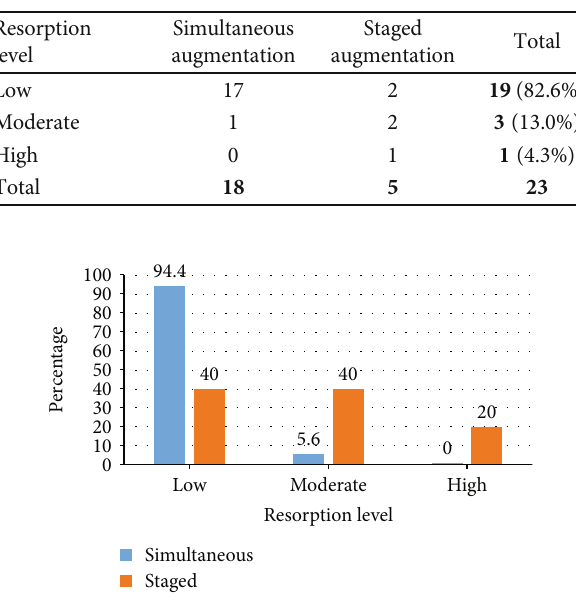
Figure 3: The resorption level of simultaneous and staged augmentation with DBBM particle. The majority (94.4%) of implant augmented with the simultaneous approach shows low resorption level, while only 5.6% is moderate and none is high level. On the other hand, with the staged approach, low resorption level is found in only 40% of implants, while the remainders are moderate (40%) and high (20%) levels. Mann-Whitney test result reveals signi fi cant di ff erence ( p = 0 : 005 ) in tissue resorption level between the two